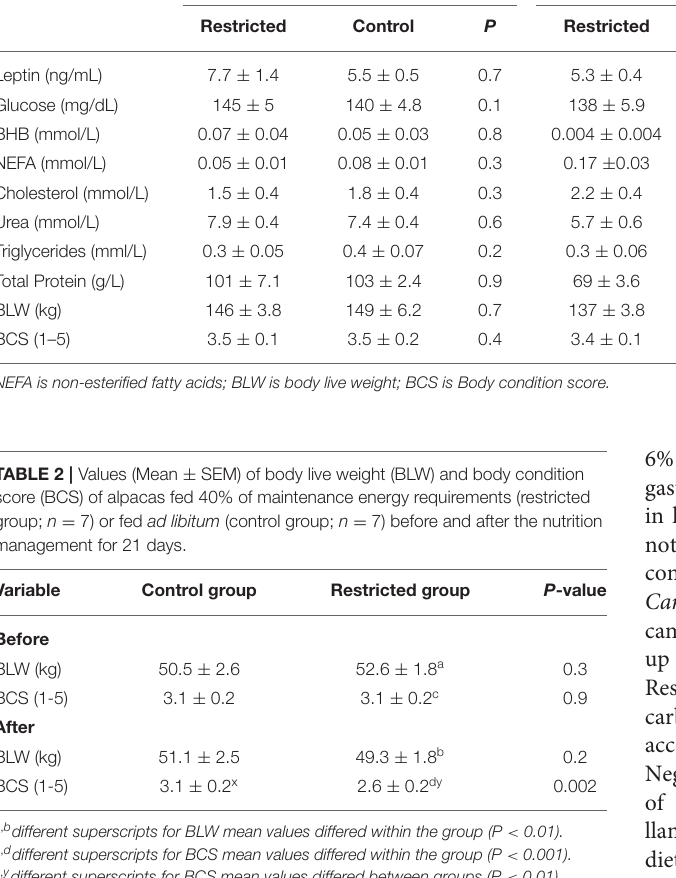
TABLE 1 | Plasma leptin concentration, metabolites, body weight and body condition score (Mean ± SEM) of llamas fed 70% energy of maintenance requirements (Restricted group; n = 7), or fed ad libitum (Control group, n = 7) during 28 days. Variable